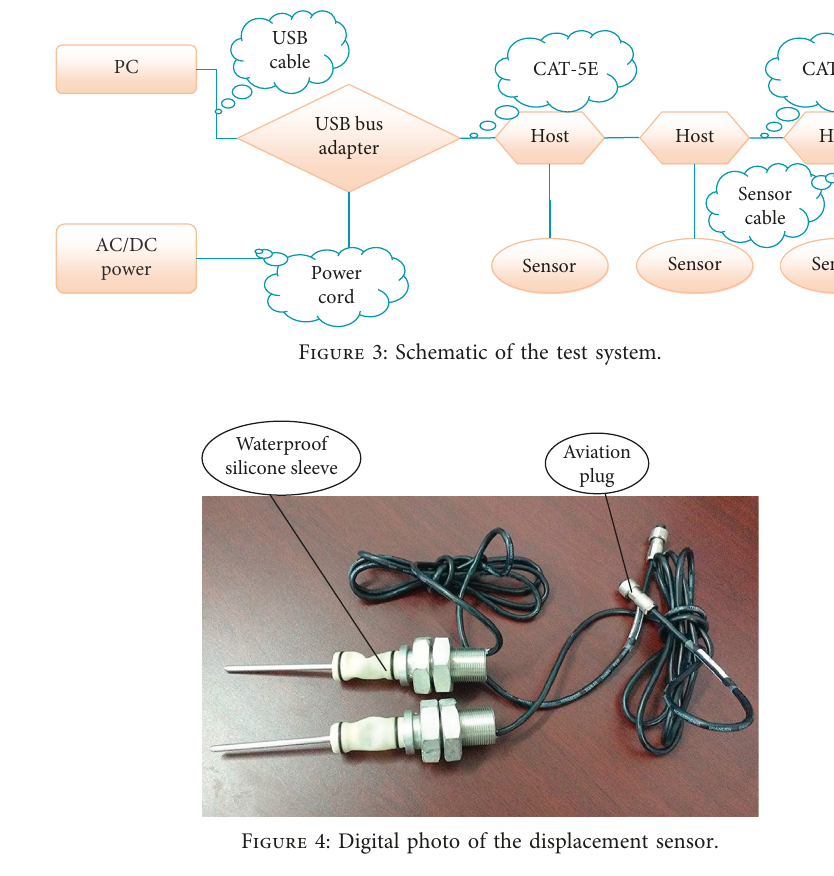
bottomDiameter 7.6